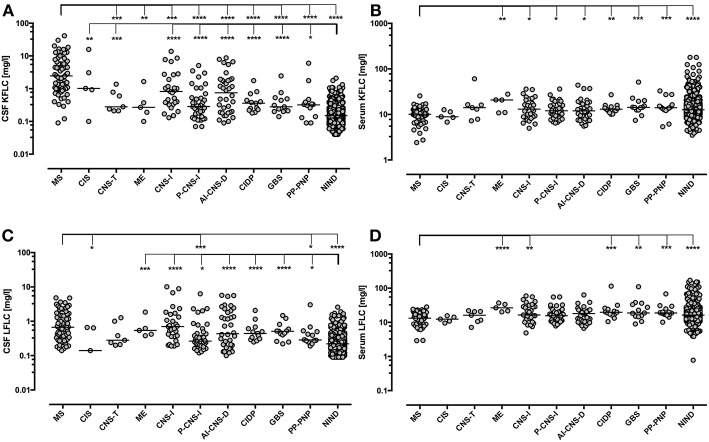
Immunoglobulin Free light chain levels in neurological diseases. Horizontal solid line indicates median. All groups have been compared to NIND and MS. Significant P-values for pairwise comparisons (Mann-Whitney U-test) are displayed. ****p < 0.0001, ***p < 0.001, **p < 0.01, *p < 0.05. AI-CNS-D, other autoimmune disease of the central nervous system; CIDP, chronic inflammatory demyelinating polyneuropathy; CIS, clinically isolated syndrome; CNS-I, viral and bacterial CNS infection; CSF, cerebrospinal fluid; GBS, Guillain-Barré syndrome; ME, metabolic encephalopathy; MS, multiple sclerosis; PP-PNP, paraproteinemic neuropathy and/or neuropathy with monoclonal gammopathy of unknown significance; NIND, non-inflammatory neurological diseases; P-CNS-I, post-infectious CSF syndrome. CSF (A) and serum (B) levels of KFLC as well as CSF (C) and serum (D) levels of LFLC are displayed.